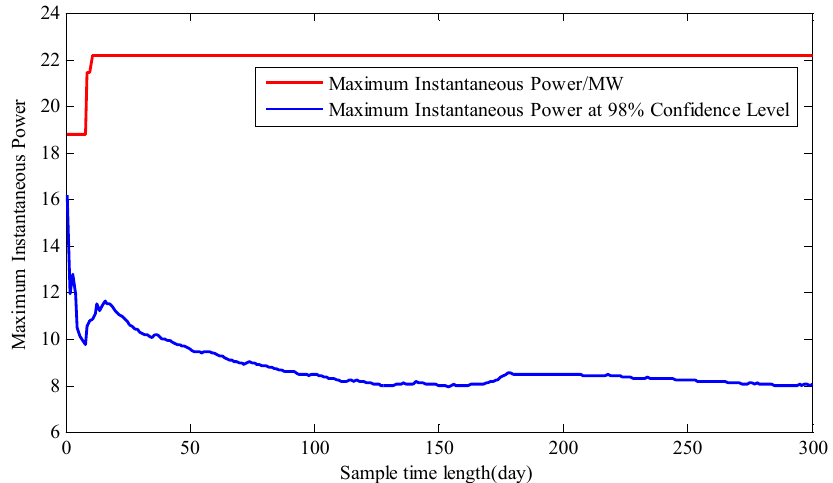
Figure 7. The relationship between the required maximum instantaneous power of energy storage systems and sampling time length.